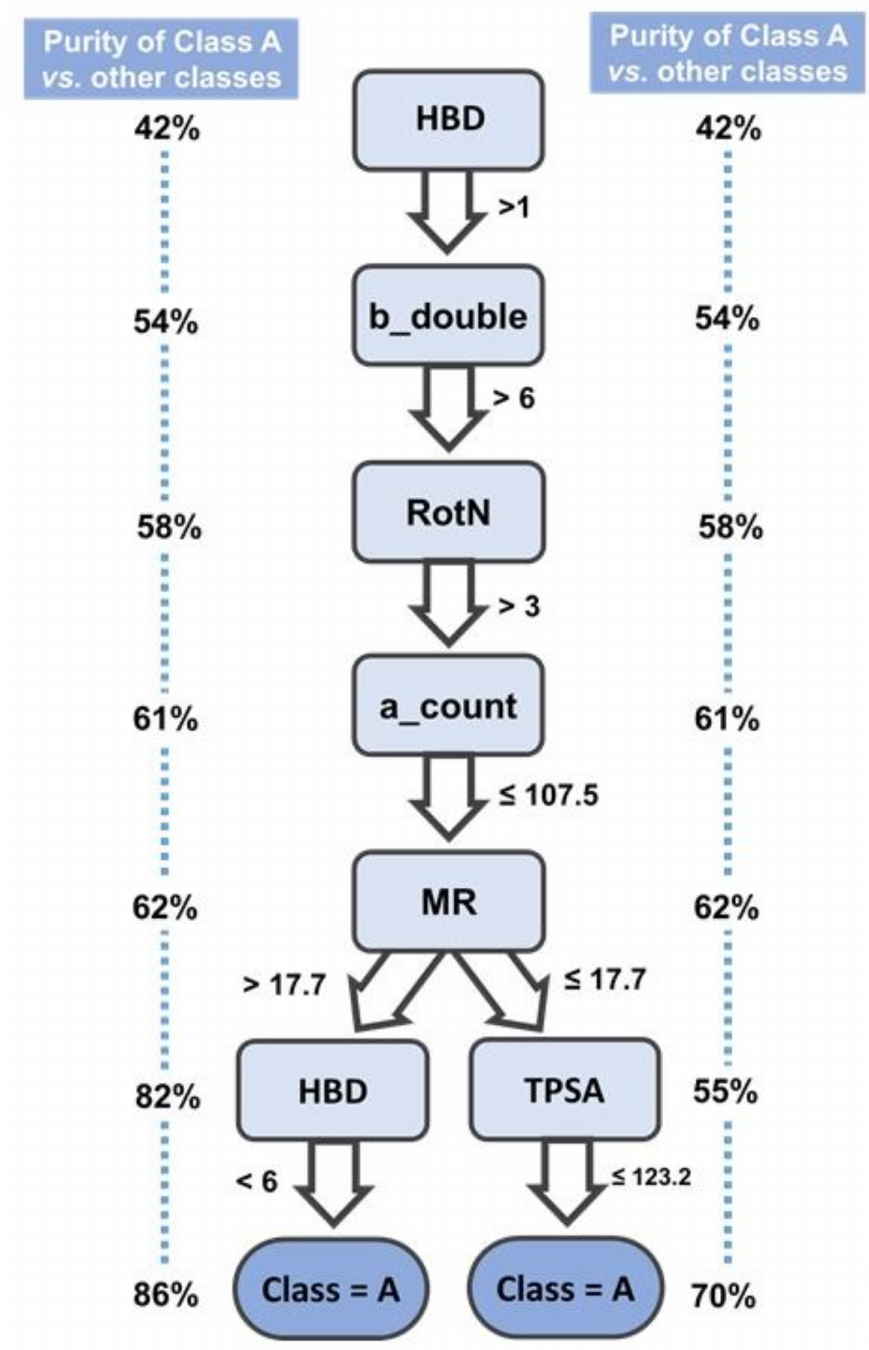
Figure 8. Schematic representation of the most important decision rules for the classification of class A compounds within the decision tree built from the proteasome inhibitors